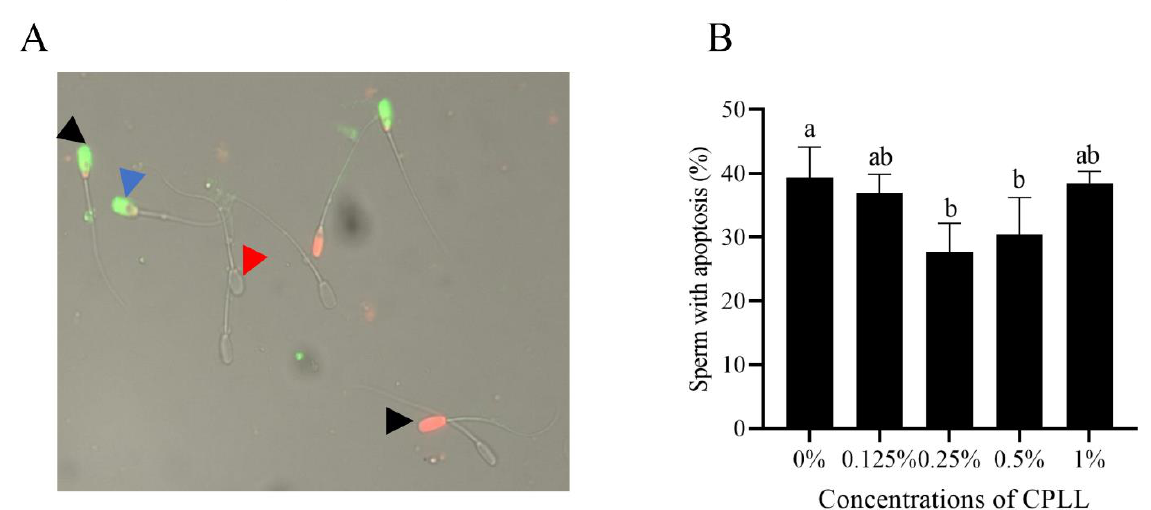
Figure 4. The images of post-thaw sperm stained with the Annexin V-FITC/PI assay kit ( A ). Blue arrow indicates the post-thaw sperm with apoptosis stained with AN + /PI − that presented green fluorescence, black arrow indicated the dead sperm stained with AN + /PI + or AN − /PI + that presented orange or red fluorescence, red arrow indicated the live sperm with no fluorescence. Effects of different concentrations of CPLL on boar post-thaw sperm apoptosis ( B ). Values are specified as mean ± standard error of the mean (SEM). Columns with different uppercase letters differ significantly ( p < 0 05), n = 5.